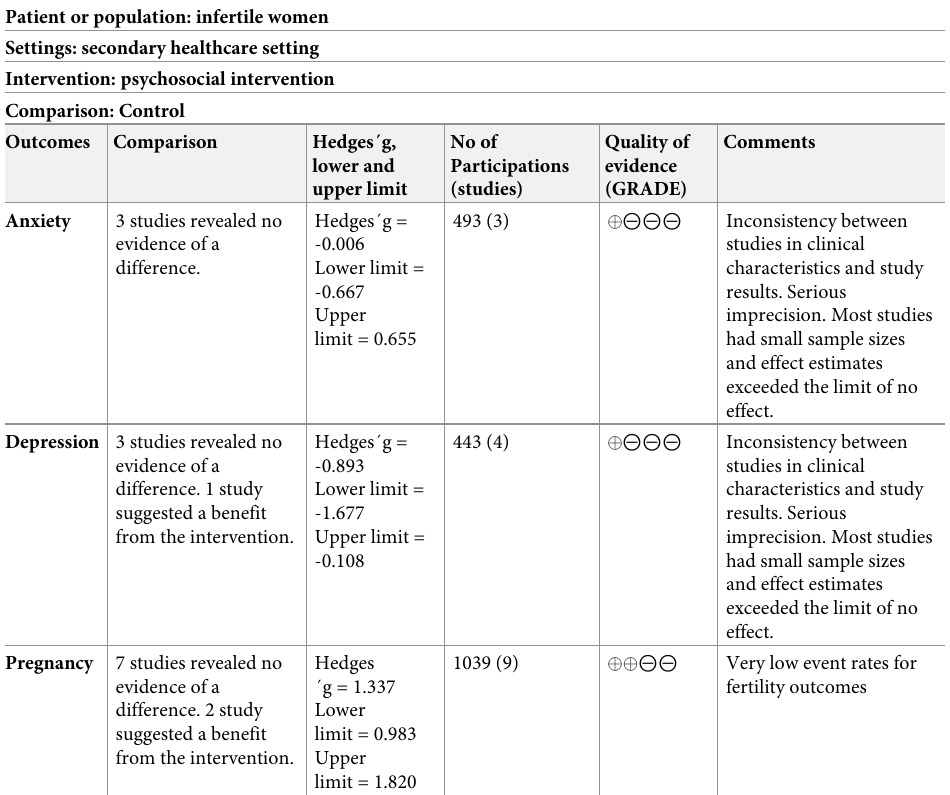
Table 4. Summary of findings: Psychosocial interventions versus control.